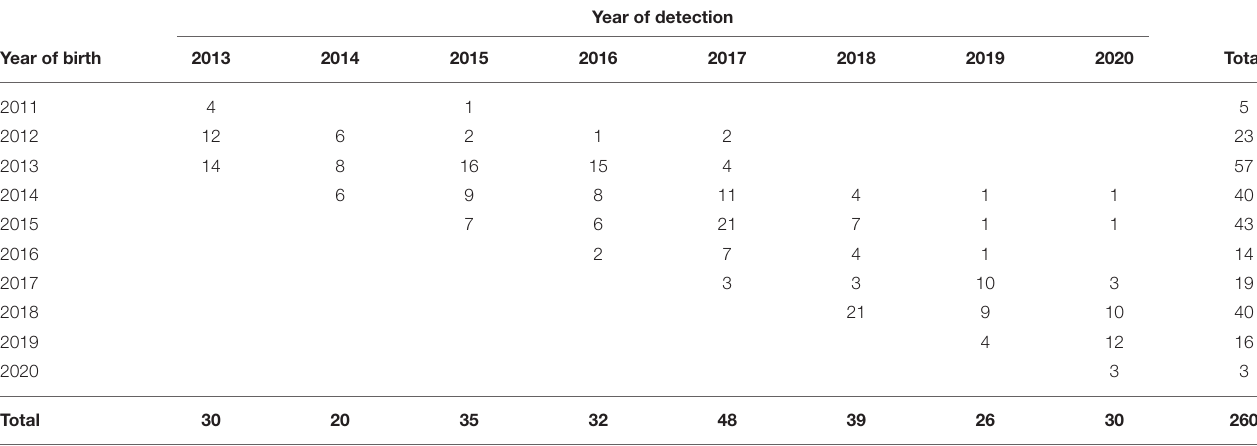
TABLE 4 | Number of animals assigned an apparent false negative (AFN) status with the programme, according to years of birth and detection. Year of